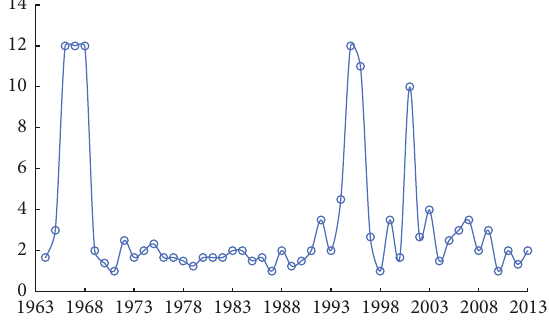
Figure 11: The interannual variability of average drought duration (number of months) from 1964 to 2013.